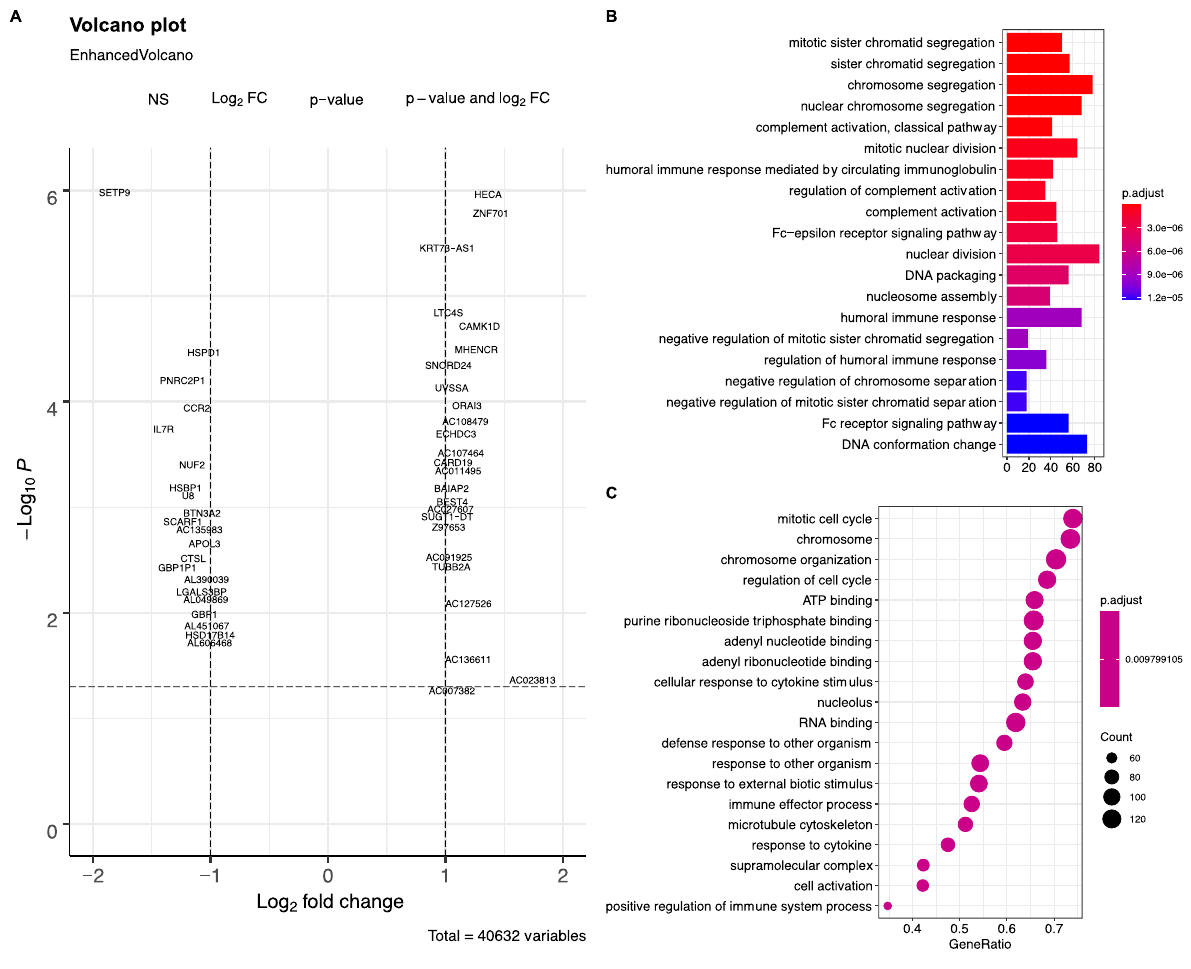
Figure 8. Differential gene expression between the sepsis and control groups. ( A ) Volcano plot showing differentially expressed genes between the sepsis and control groups. ( B ) GO enrichment analysis with the overrepresentation method. ( C ) Gene set enrichment analysis with GO